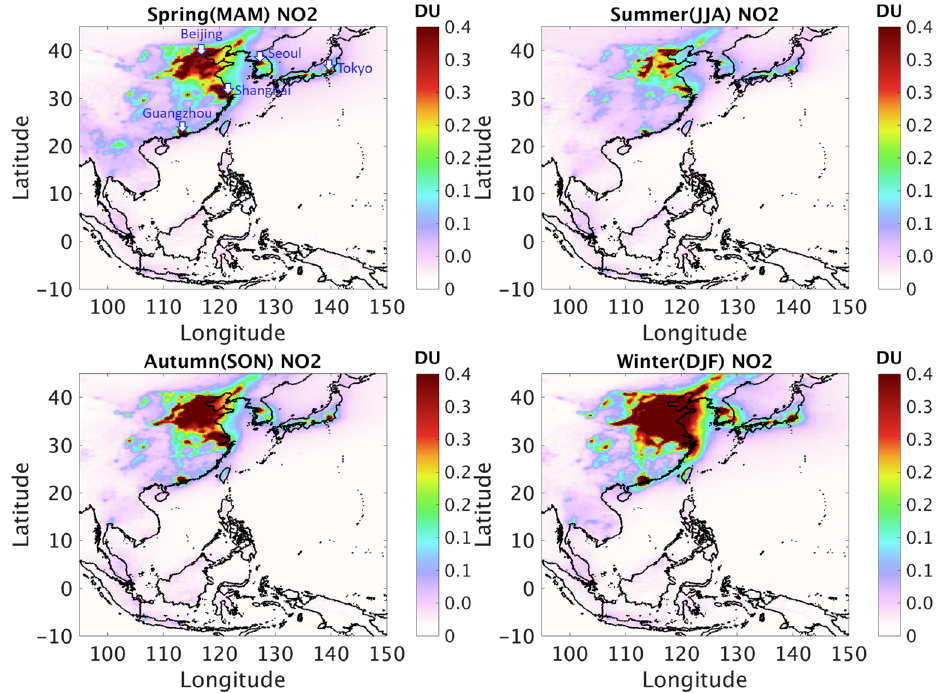
Figure 4. Spatial distribution of tropospheric nitrogen dioxide (NO 2 ) from Aura OMI for each